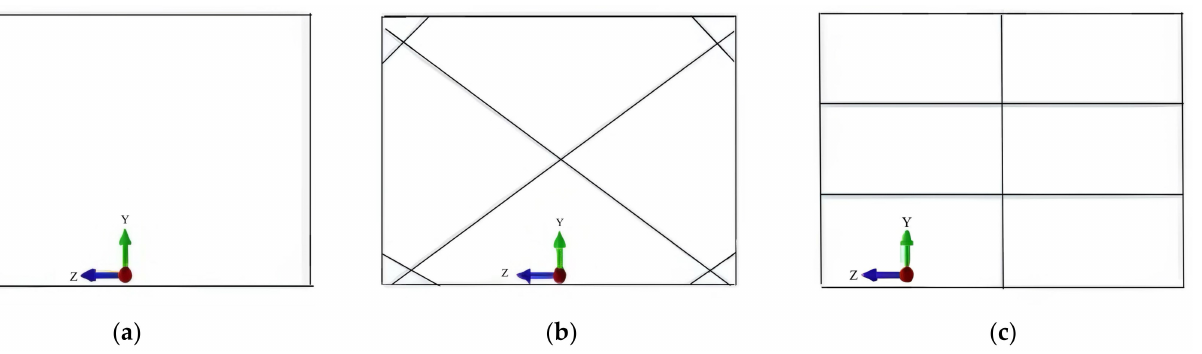
Figure 13. SPSW stiffener arrangement. ( a ) A075. ( b ) A075-P. ( c )